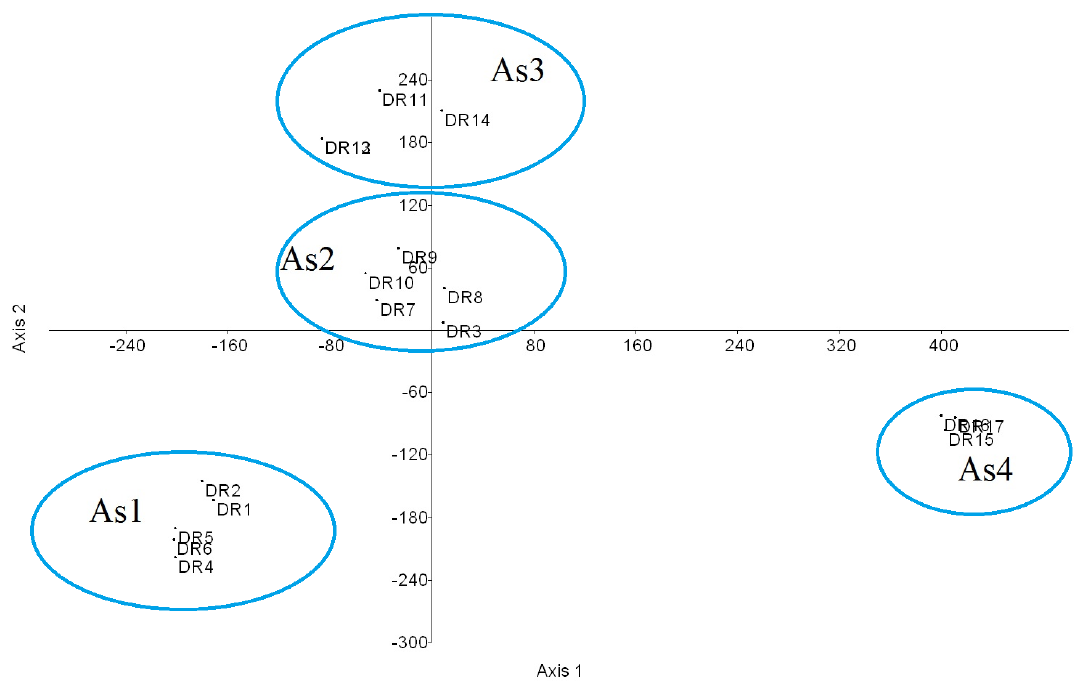
Figure 3. Detrended correspondence analysis (DCA). DCA analysis confirming the separation of the four associations (As1 Hyeronimo montanae - Magnolietum pallescentis ; As2 Cyatheo furfuracei - Prestoetum montanae ; As3 Hyeronimo dominguensis - Magnolietum hamorii ; As4 Ormosio krugii - Prestoetum montanae ) found in Dominican Republic (DR) relevés.